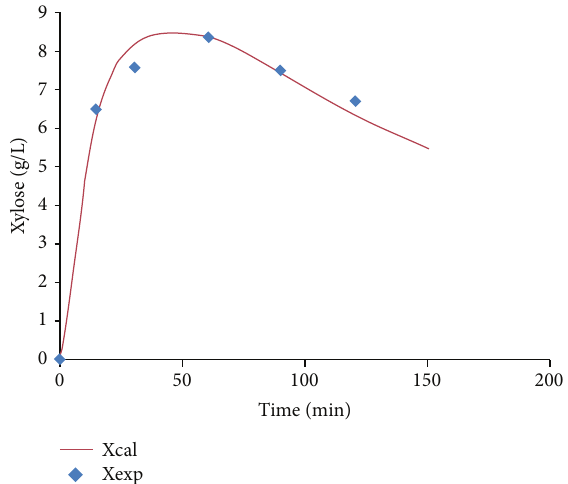
Figure 3: Comparison between calculated and experimental value of xylose in hydrolysis of OPEFB with 6 % H 2 SO 4 at 120 ∘ C [95].